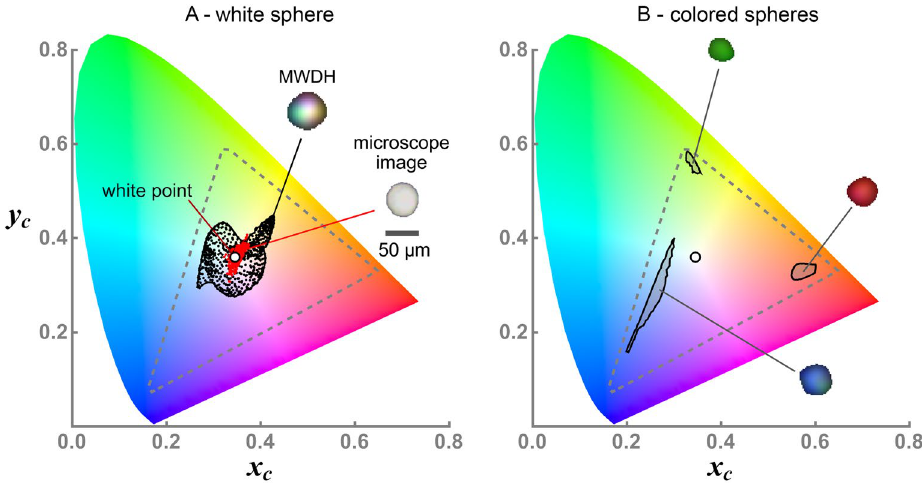
Figure 2. Chromaticity analysis (CA) of backscatter MWDH images of free-flowing, spherical aerosol particles. A single white aerosol particle is considered in ( A ) where the MWDH and optical microscope images are shown inset with a 50 µ m scale bar. For each image, the chromaticity points ( x c , y c ) for each image-pixel are plotted in the color space for the MWDH image (plack points) and microscope image (red points). The sensor color- space is shown by the dashed triangular region. A contour around the point-groups defines the chromaticity signature and both signatures surround the color-space white point indicating an overall white appearance of the particle image. Note that the microscope image is taken for a representative particle from the stock powder from which the aerosol is generated. So, this image does not show the same particle as the aerosol (MWDH) image. In ( B ) is shown the MWDH images of single red, green, and turquoise spherical aerosol particles and their corresponding chromaticity signatures. Due to the relatively pure-color appearance of each particle, their corresponding signatures are isolated near the corners of the color space. Notice that the colors displayed in the particle images here appear darker than the associated colors outlined in the chromaticity plot. Recall, however, that CA does not depend on the brightness of a given color (see “Methods” section), and hence, the same colors are being